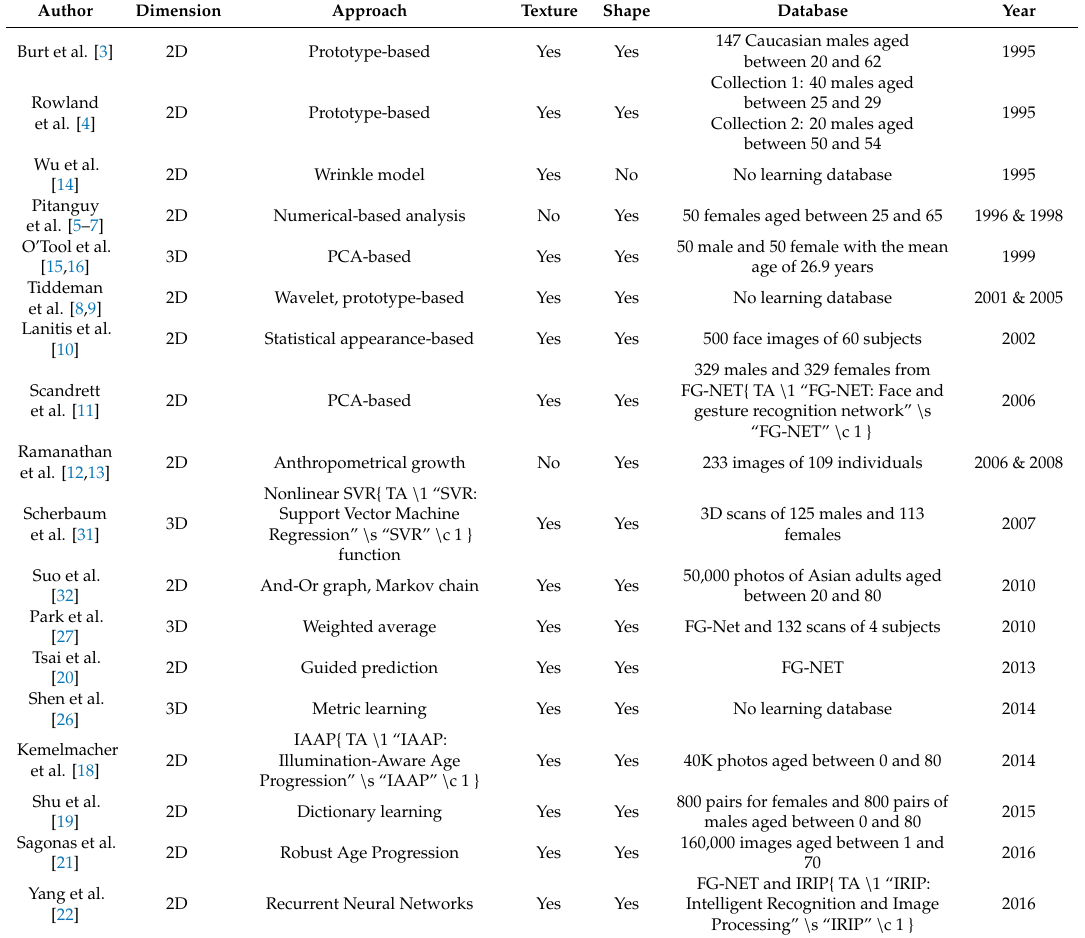
Table 1. A list of notable contributions to the facial aging modeling